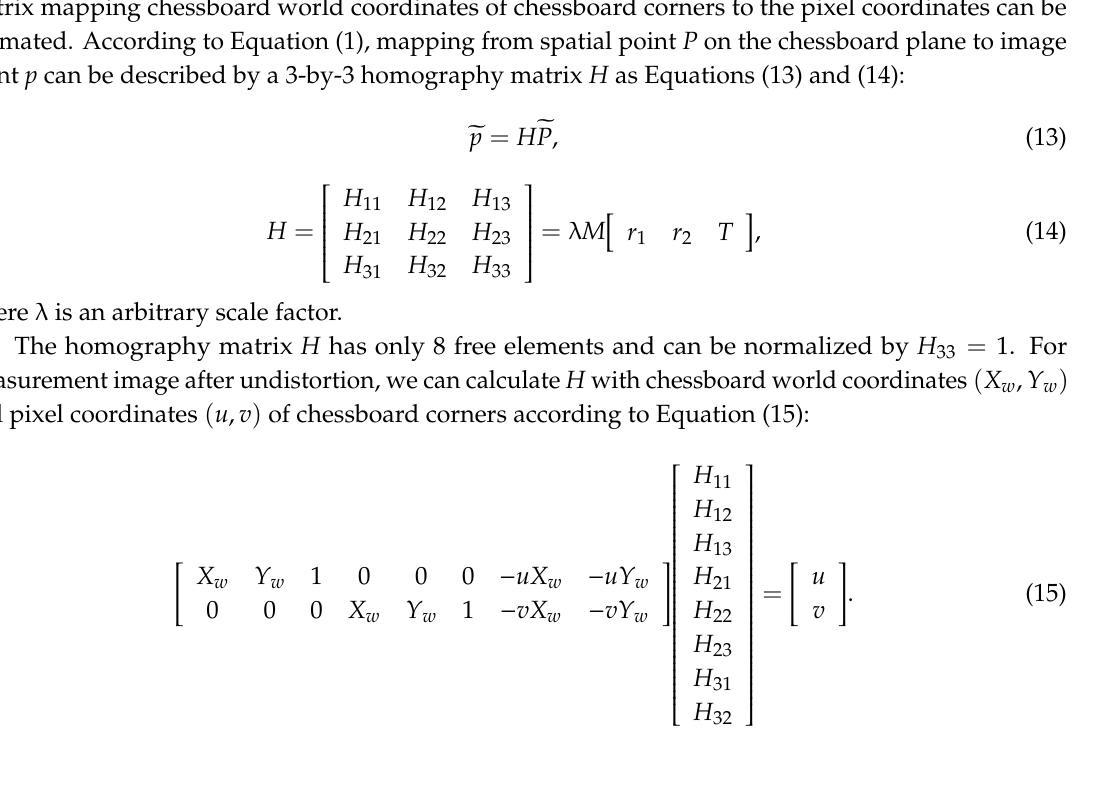
Figure 9. LTBC to V ρ of I-Mutation, in which vertical axis is radial distance to the fitted circle, and horizontal axis is the dynamic number rather than polar angle θ , to avoid the discontinuity of clockwise θ ranging from 180 ◦ to − 180 ◦ . The blue lines are Step 0 , red lines are corresponding fitted lines, the magenta and green solid lines are detected I-Mutation, black arrow is the translation for Step b correction, and the magenta and green dashed lines are corrected